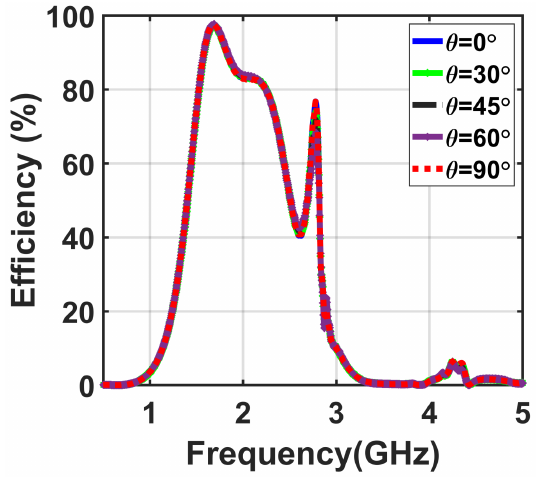
Figure 11. Numerical results of the 8 × 8 dual polarized planar metasurface, demonstrating the radiation to AC conversion efficiency as a function of frequency for various incident